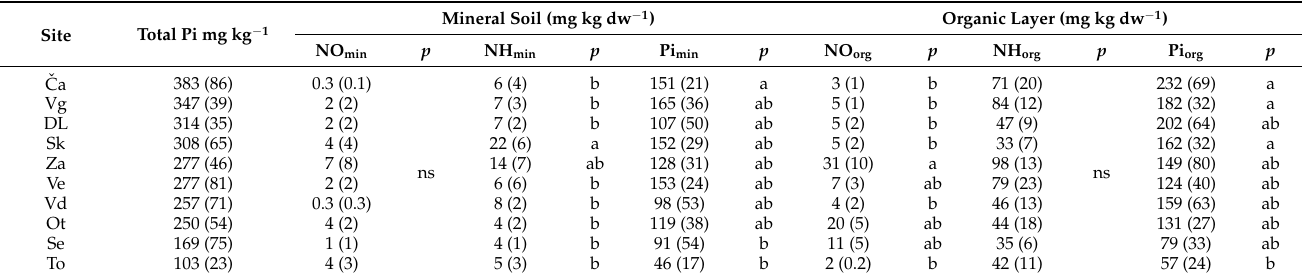
Table 2. Plant available N and Pi in the soil at 10 beech forest sites in Croatia. p indicates results of one-way ANOVAs at p < 0.01. Different minor letters represent statistically significant differences between ecotypes at p <